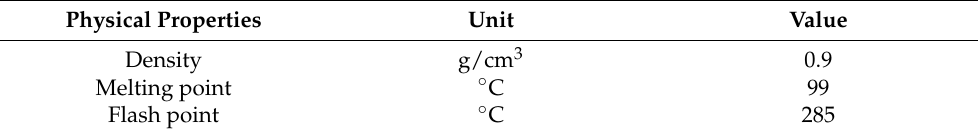
Table 4. The physical properties of wax modifier.